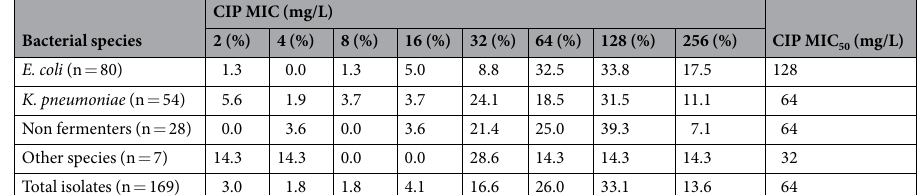
Table 1. CIP MIC 50 and MIC distribution among isolates of various species recovered from cancer patients. Other species, C. freundii, E. aerogenes, E. cloaceae, K. oxytoca and P. mirabilis ; Non-fermenters, A. baumannii and P. aeruginosa . CIP MIC 50 , ciprofloxacin MIC at which 50% of the isolates were inhibited.